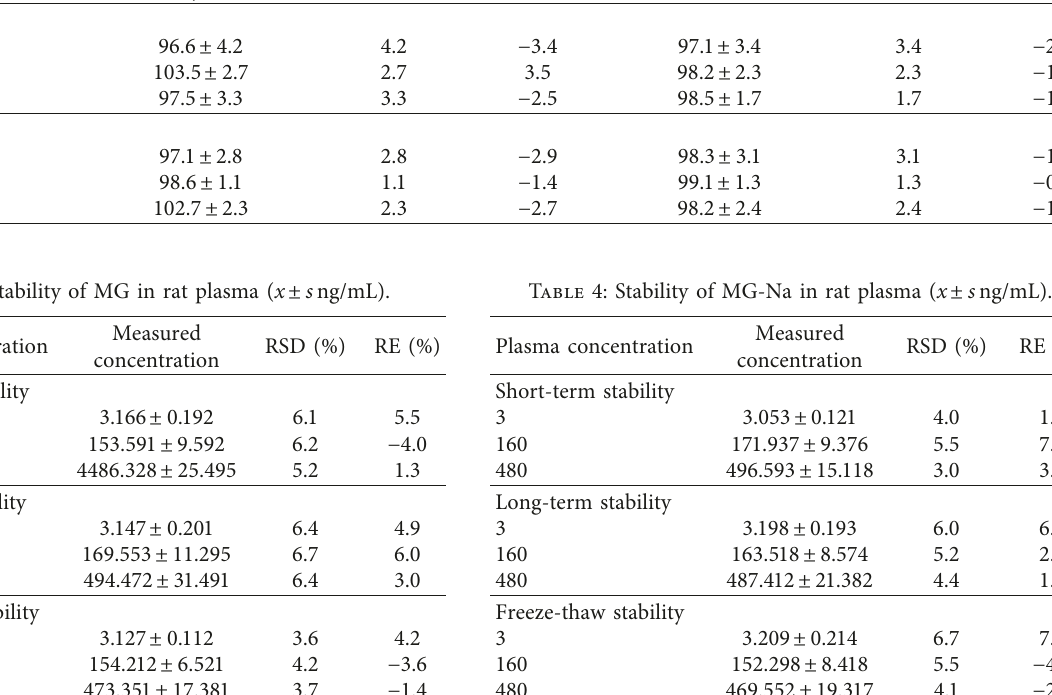
Table 2: Extraction recovery and matrix effects of MG and MG-Na in rat plasma ( x ± s ng/mL). Plasma concentration